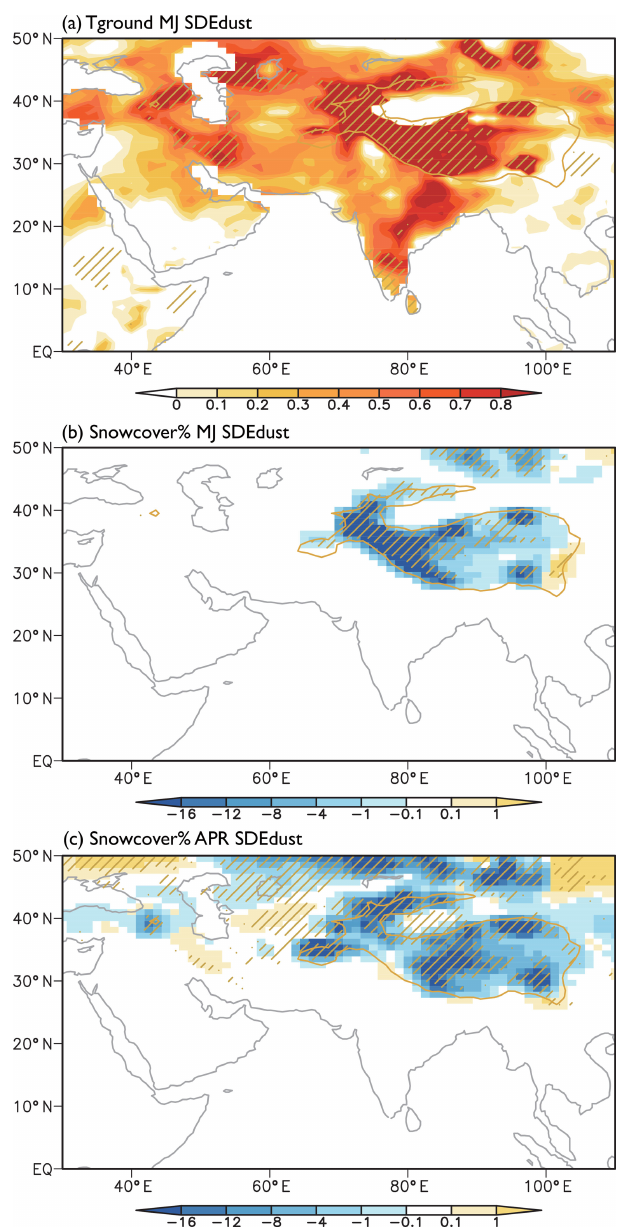
Figure 12. Changes in surface ground temperature in May and June ( ◦ C, a ) and snow cover fraction during May to June (%, b ) and April (%, c ) induced by the snow-darkening effect. Oblique lines indicate differences significant at the 95% confidence level. Yellow line shows the profile of the Tibetan Plateau above 2500m.